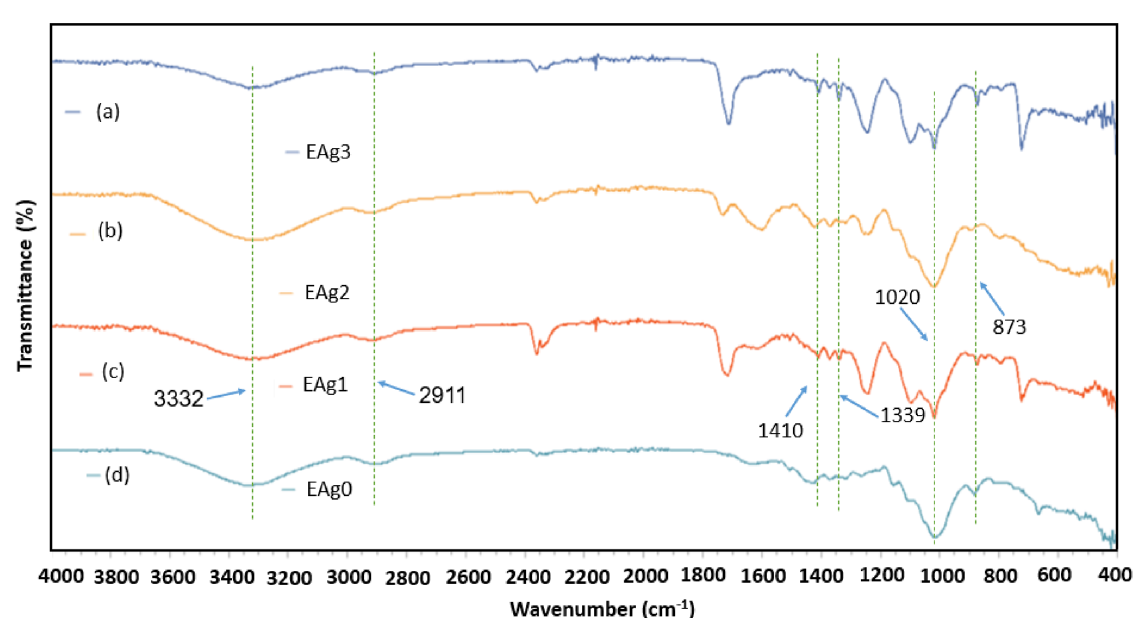
Figure 7. FTIR investigation of control and nanosilver-coated sisal/cotton interwoven